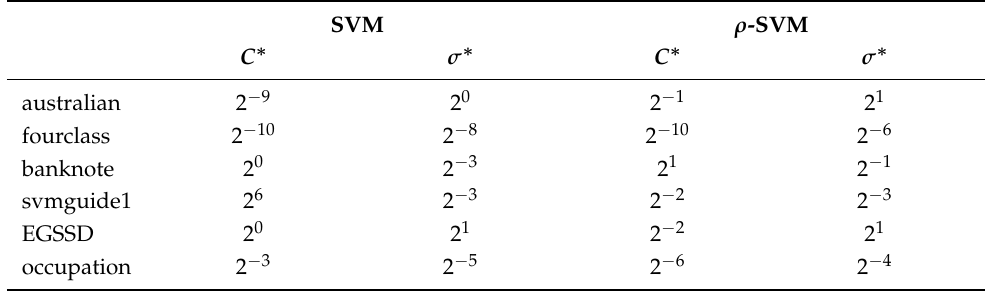
Table 3. Optimal parameter values after grid search. SVM ρ -SVM C ∗ σ ∗ C ∗ σ